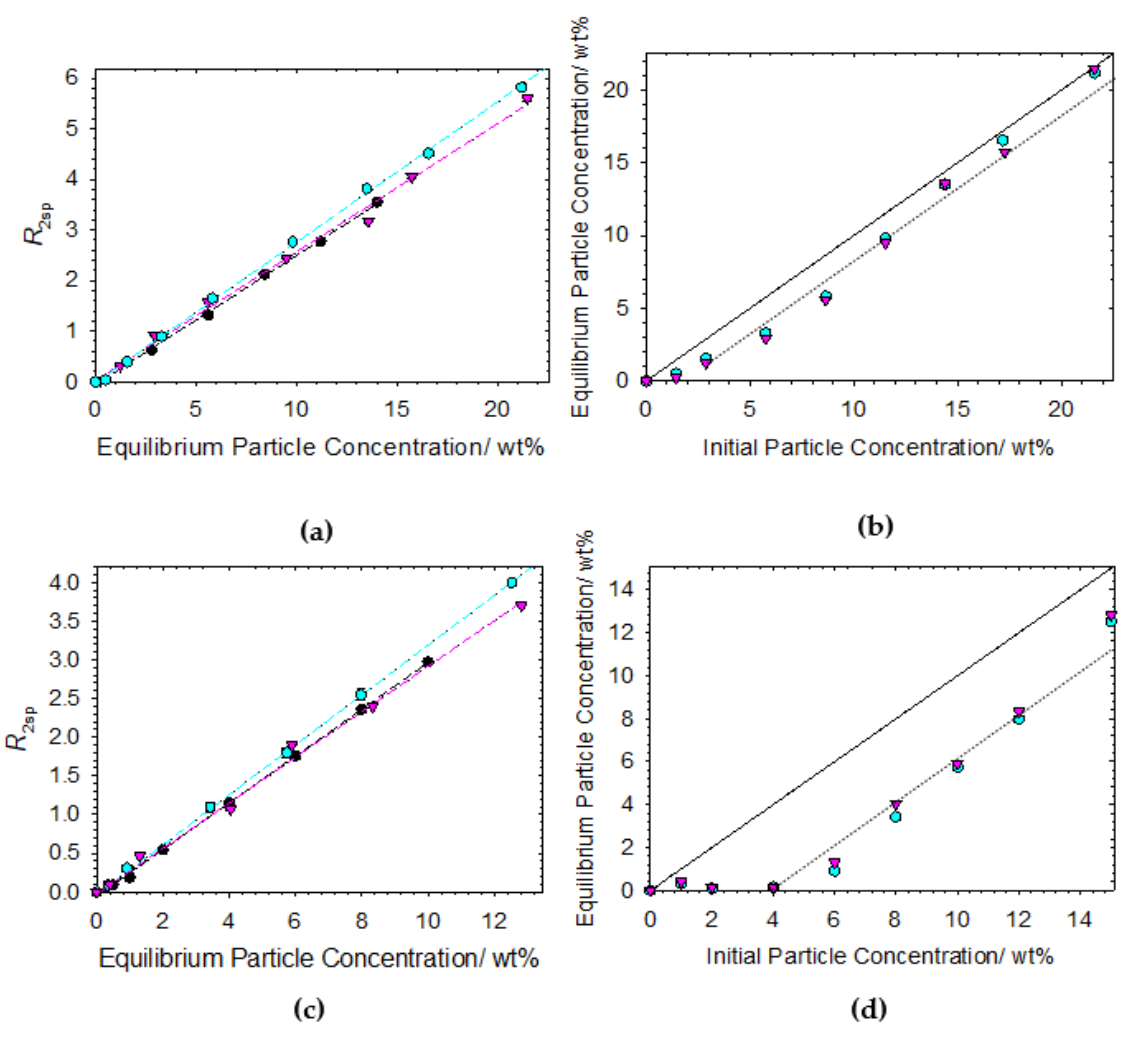
Figure 5 . ( a , c ) Specific relaxation rates as a function of the equilibrium particle concentration for mixtures containing cat-HEC ( n = 0.95%), 0.5 × CMC C 12 E 6 and Ludox ( a )/Latex ( c ). Regression plot is through each data set. ( b , d ) Equilibrium particle concentration as a function of initial particle concentration for the mixtures containing Ludox ( b ) and Latex ( d ). X = Y plots in ( b ) and ( d ) are included as guides for the eye; dotted lines are linear offsets from the X = Y plot. Symbols: ● , particle only; ⬢ , 0.5 × CMC C 12 E 6 + 0.1 wt% cat-HEC polymer; ▼ , 0.1 wt% cat-HEC polymer.